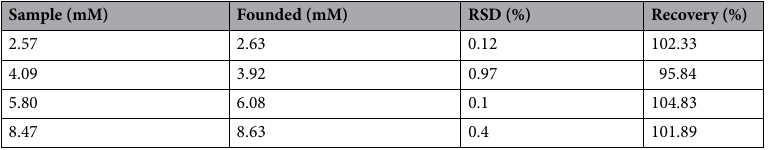
Table 2. Recovery and relative standard deviation (RSD) of Nafion/CuO/ZnO-DSDSHNM/GCE for detecting glucose in a real serum